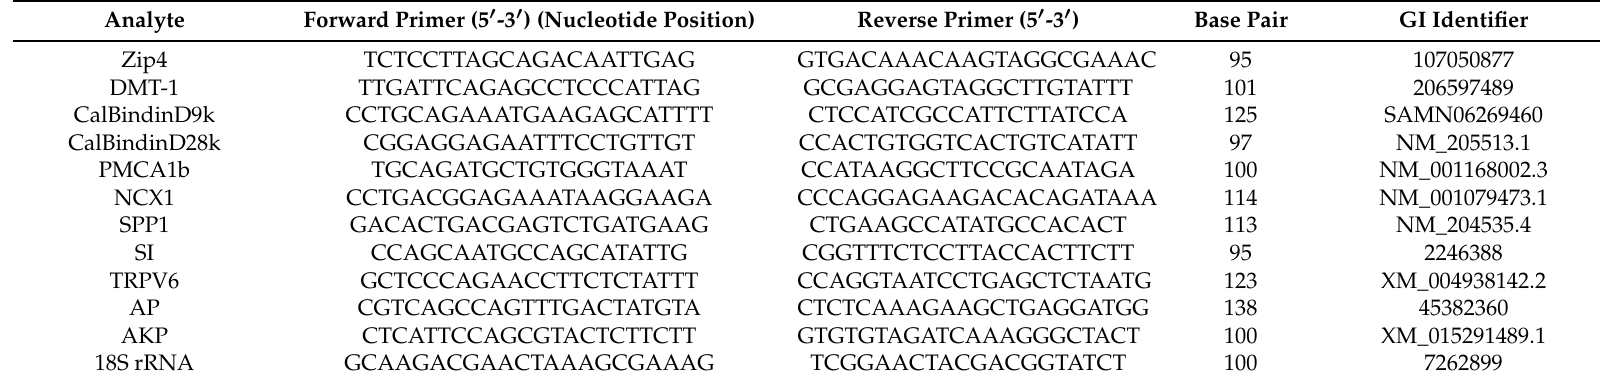
Table 1. DNA sequences of the primers used in this